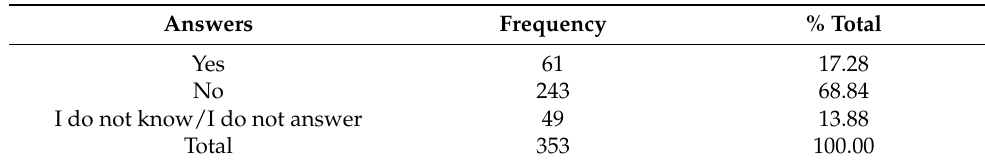
Table 7. Results for the attitude of the believers about the action of the former Metropolitan of Kalavryta.